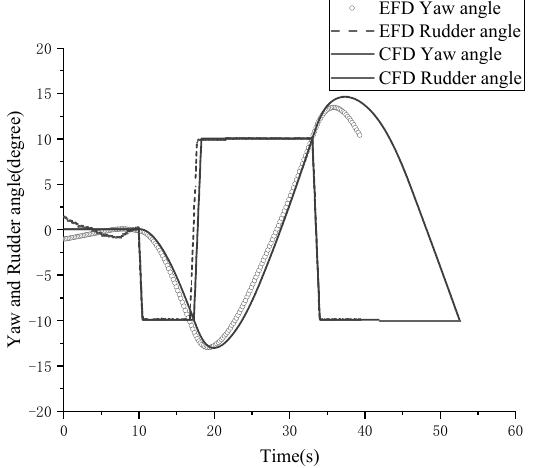
Figure 24. Heading and rudder angle in − 10° zigzag maneuver.